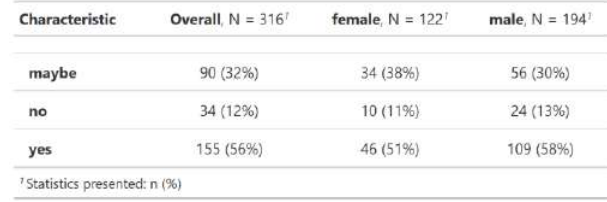
Table 25: If you are given an opportunity to study in India, would you like to go? (Source: Authors‟ depiction